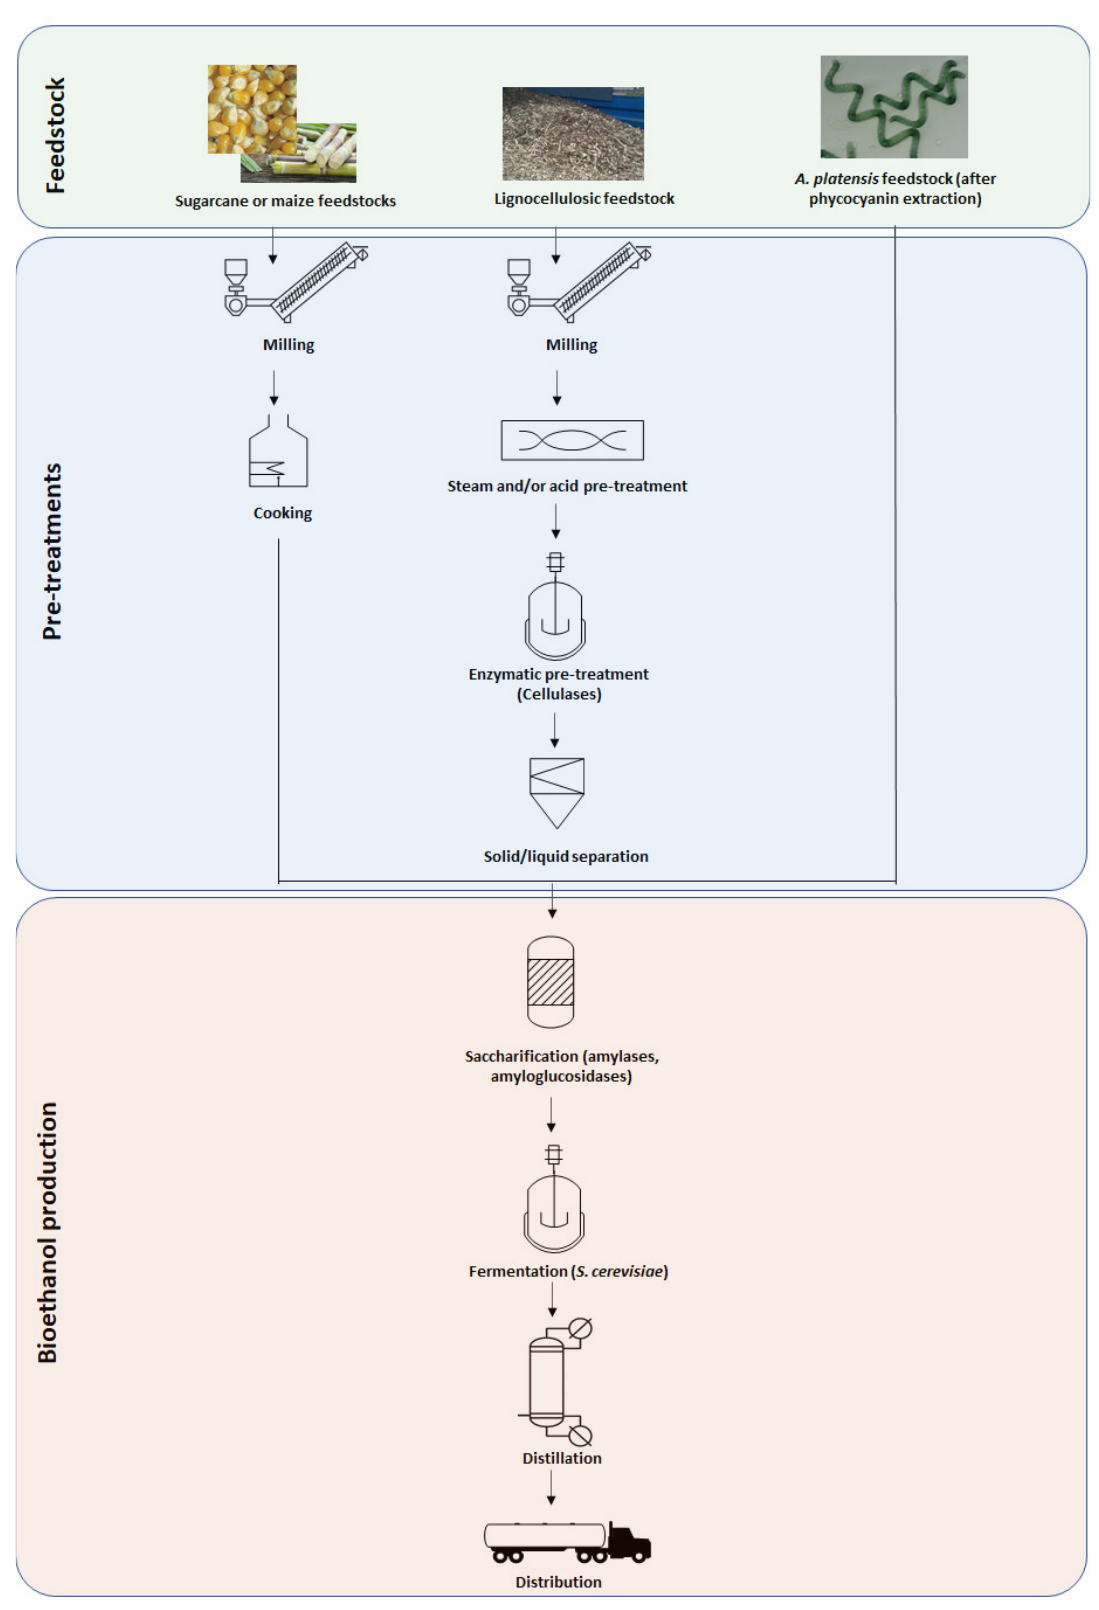
Figure 1. Comparison of process flow diagrams for bioethanol production, depending on the feedstocks.